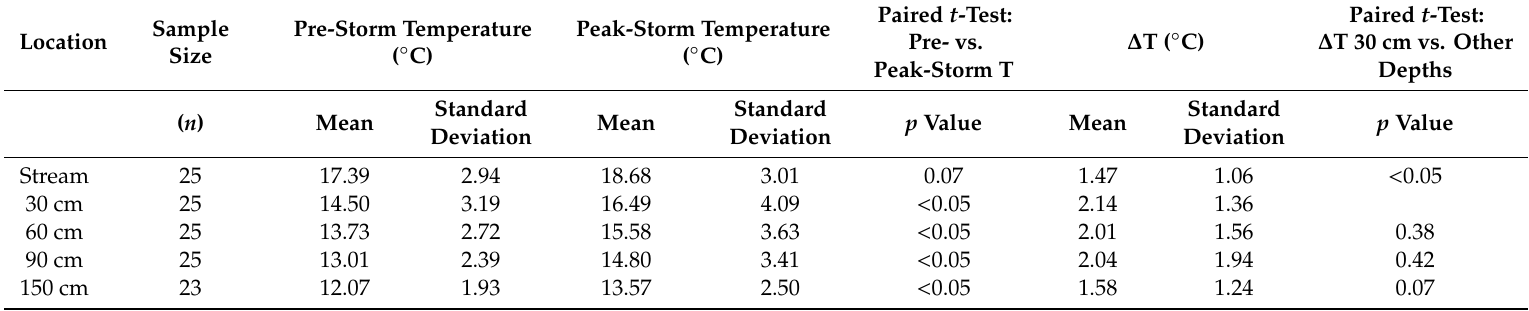
Table 2. Summary statistics of warm pre- and peak-storm temperatures and after-storm thermal amplitude change ( ∆